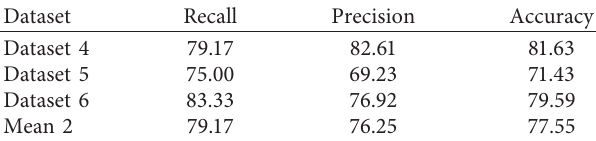
Table 6: Results of SVM model for Datasets 4–6.